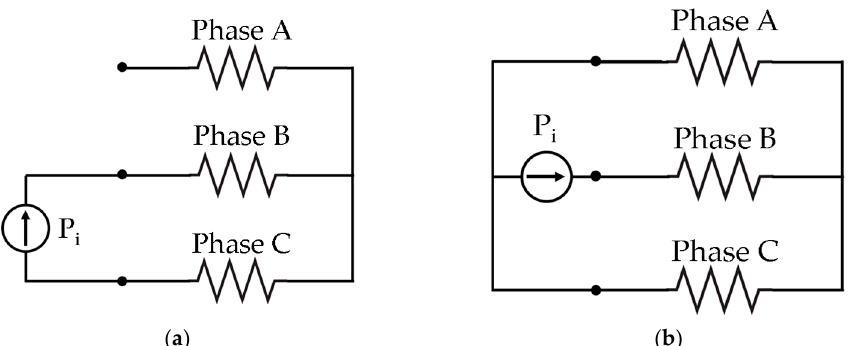
Figure 3. Stator winding connections for the dc supply: configuration ( a ) (left); configuration ( b ) (right).